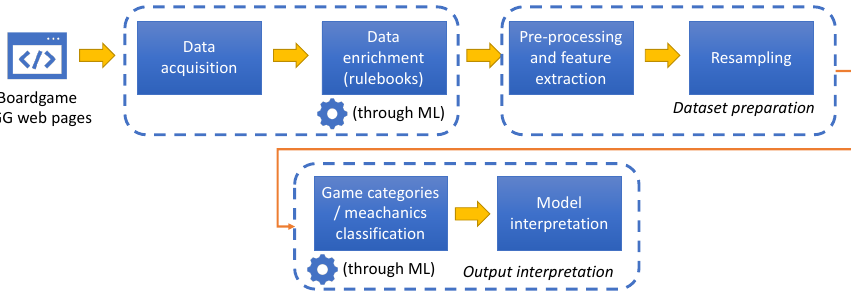
Figure 4. Dataset acquisition, preparation and analysis pipeline for the game analytics